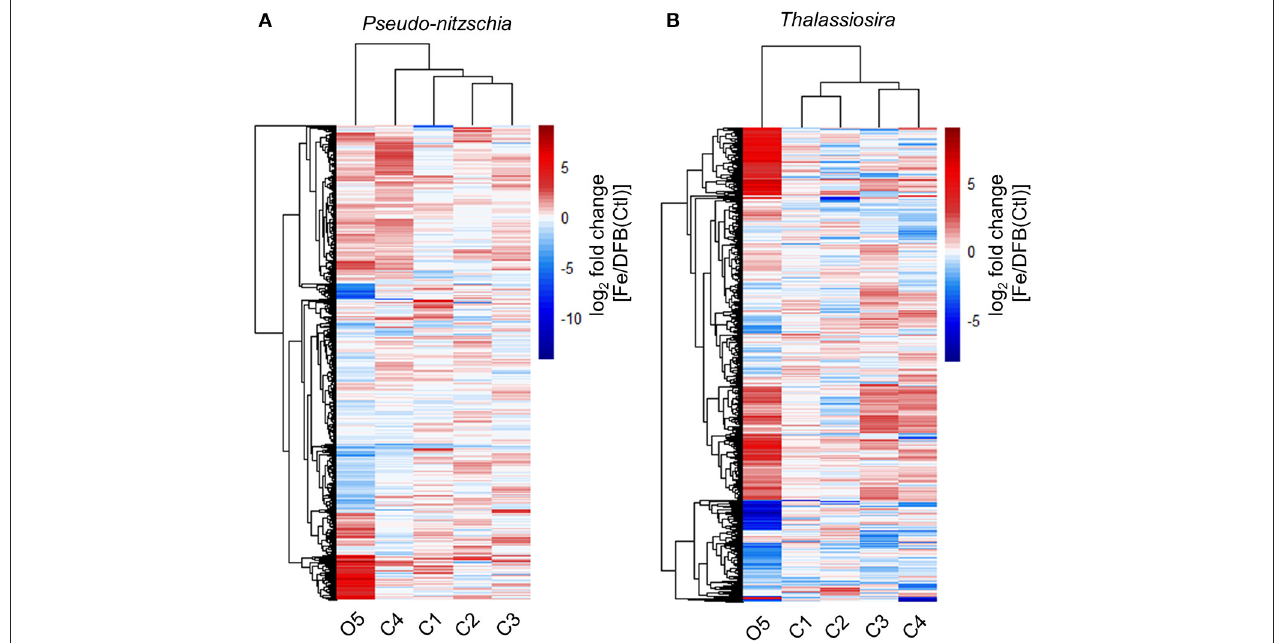
FIGURE 4 | Differential expression response of shared KEGG Orthologs (KOs) between the Fe and DFB treatments at T 1 in the diatom genera Pseudo-nitzschia (A) and Thalassiosira (B) . Heatmap represents the log 2 fold change in gene expression within the Fe addition treatment relative to the DFB addition treatment at each site. For site O5, the T 2 control (Ctl) treatment is used as the Fe-limited comparison. Only KOs with transcript abundances > 5 log 2 CPM are included. Dendrograms reflect similarity in expression responses among sites (columns) or KOs